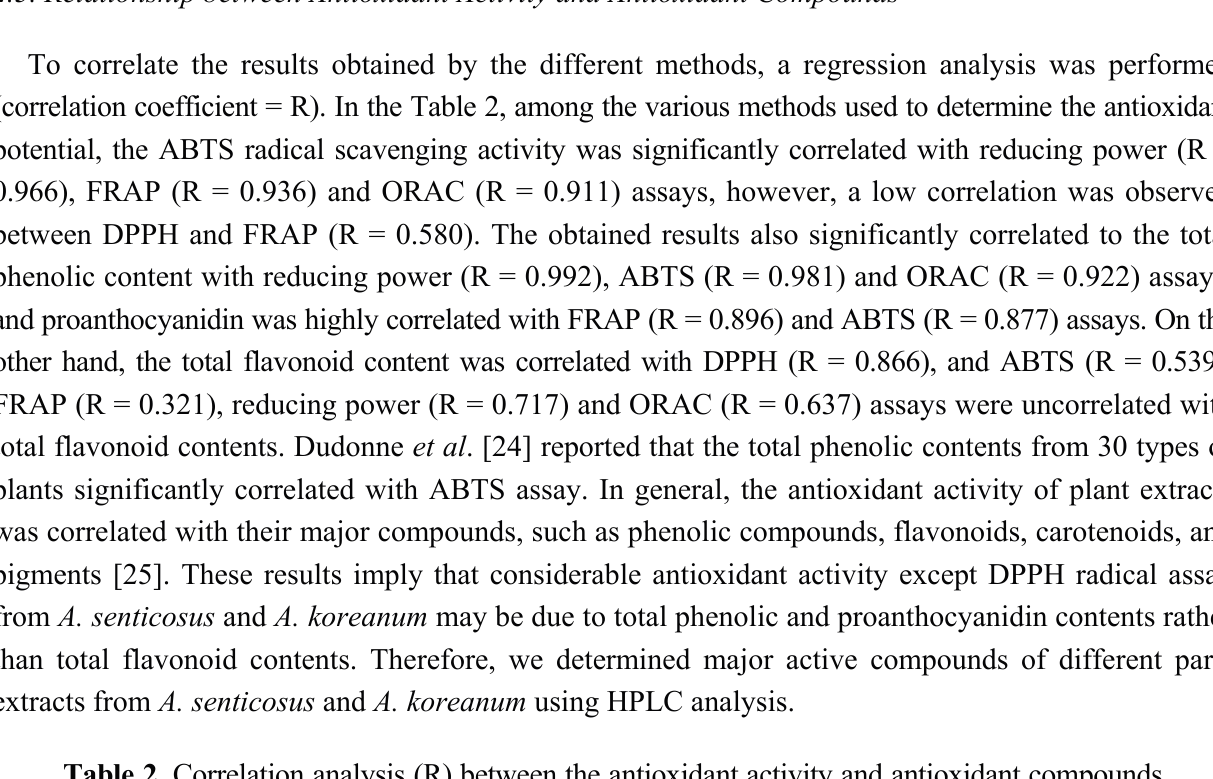
Table 2. Correlation analysis (R) between the antioxidant activity and antioxidant compounds in the different parts of A. senticosus and A. koreanum